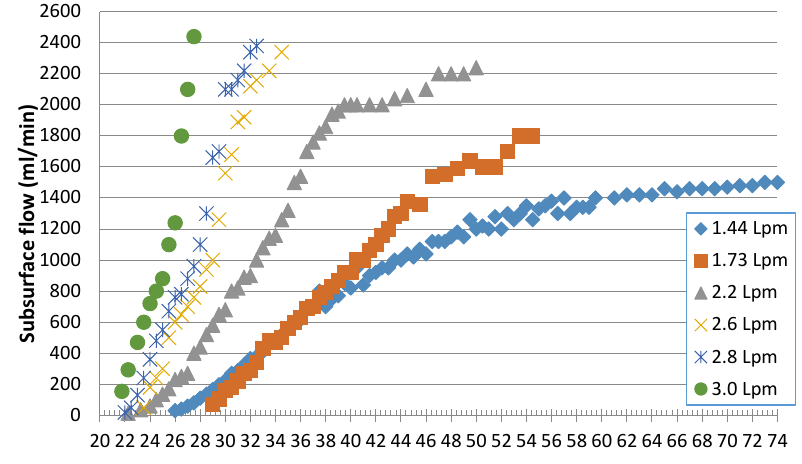
Figure 7. Sandbox subsurface outflow rate at 2 m downslope as it depends on elapsed time after onset of onflow at rates listed for 51.8% bed slope and 143 mm depth sand. All tests under conditions of previous ‘natural drainage’.